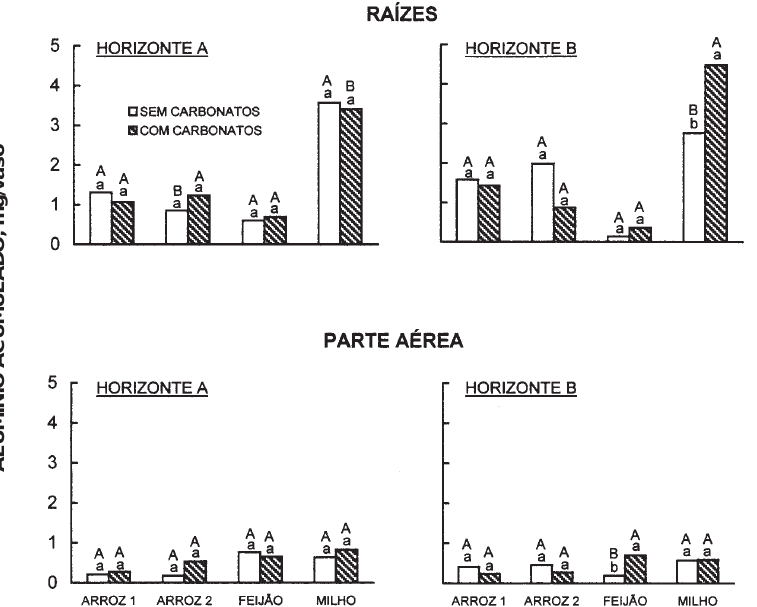
Figura 3. Quantidades de alumínio acumuladas em plantas cultivadas em amostras dos horizontes A (com 0,8 cmol dm -3 de Al trocável) e B (com 14,5 cmol dm -3 de Al trocável) de um Podzólico Vermelho- c c Amarelo do estado do Acre, tratadas ou não com carbonatos de cálcio e de magnésio (Arroz 1, cultivar Fernandes; Arroz 2, cultivar IAC 1131). Letras maiúsculas e minúsculas acima das barras comparam horizontes e doses de carbonatos, respectivamente, pelo teste de Tukey a